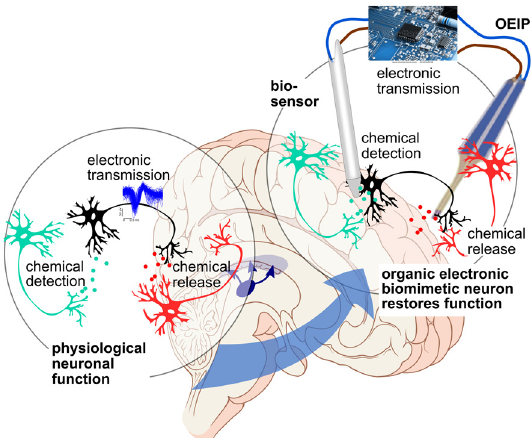
Figure 2. Organic electronic biomimetic neuron (OEBN). A normal physiological neuronal function is characterised by chemical-to-electrical-to-chemical signalling. A neuron senses neuron. The action potential eventually triggers the release of neurotransmitters at the